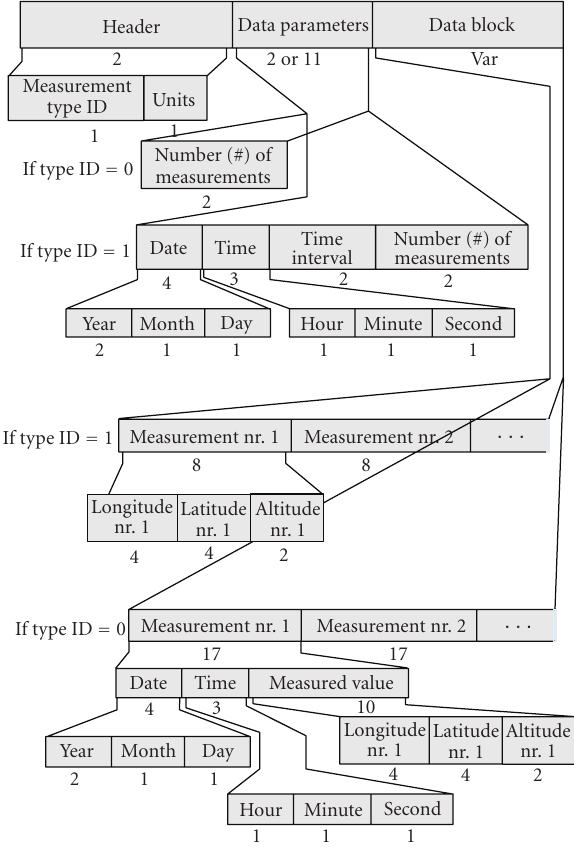
Figure 8: Overview of the data part holding the GPS data (Section- 207).